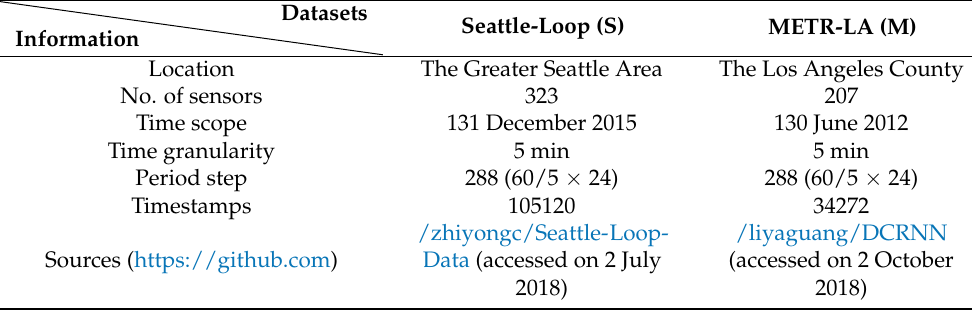
Table 1. Summary statistics of the Seattle-Loop and METR-LA traffic speed Figure 2. Schematic of the spatial-temporal matrix factorization (white boxes denote missing data).